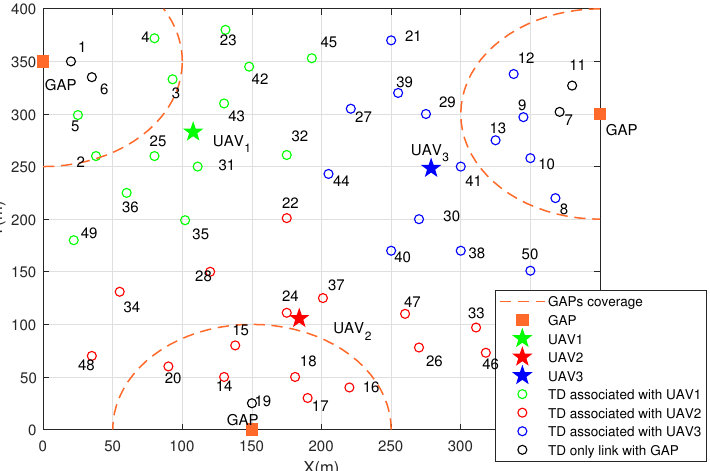
Figure 3. 2D deployment of UAVs and association.